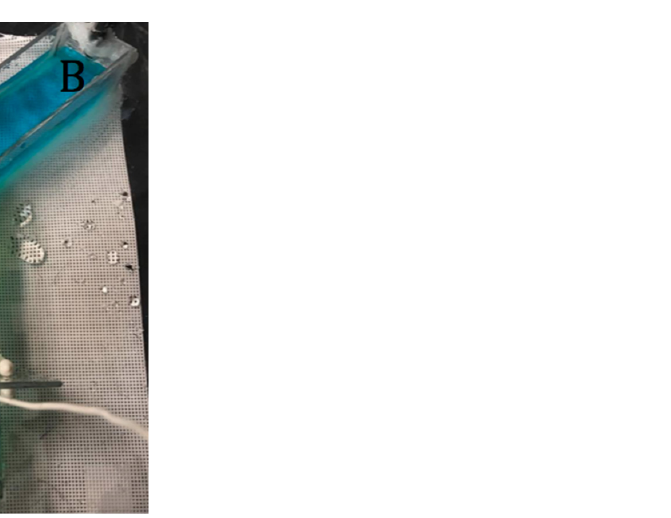
Figure 2. Y-maze apparatus. Blue and yellow dyes demonstrate symmetrical flow from each arm or branch ( A and B ) into the base arm ( C ) where shrimp is initially placed prior to starting a trial.